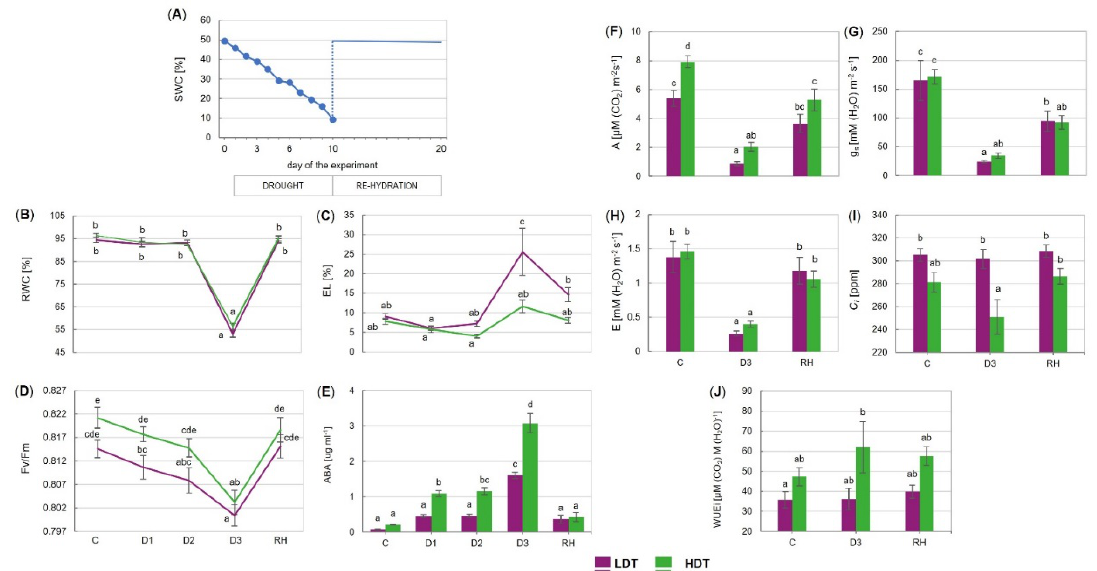
Figure 1. ( A ) Changes in soil water capacity (SWC) in the pots during the experiment. ( B ) Relative water content (RWC), ( C ) electrolyte leakage (EL), ( D ) maximum quantum e ffi ciency of photosystem II photochemistry (Fv / Fm), ( E ) accumulation of abscisic acid (ABA), ( F ) CO 2 assimilation (A), ( G ) stomatal conductance (g s ), ( H ) transpiration (E), ( I ) internal CO 2 concentration ( Ci ), and ( J ) intrinsic water use e ffi ciency (WUEi) of two L. multiflorum / F. arundinacea introgression forms (low- and high-drought tolerant—LDT and HDT, respectively) at di ff erent time points: before stress treatment (C), on the 3rd (D1), 6th (D2), and 10th (D3) day of the water deficit and 10 days after re-hydration (RH). Error bars represent the standard errors. Homogeneous groups are denoted by the same letter according to Fisher’s LSD test ( p = 0.01).